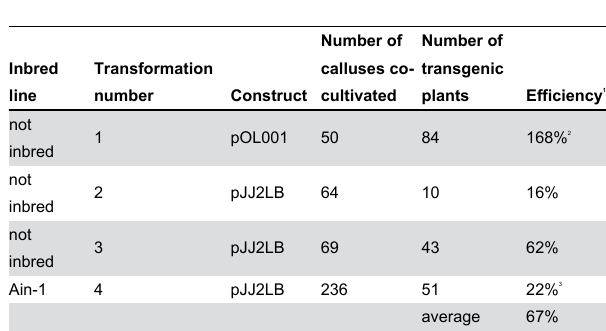
Table 3. Transformation of accession PI269842 and the inbred line Ain-1.